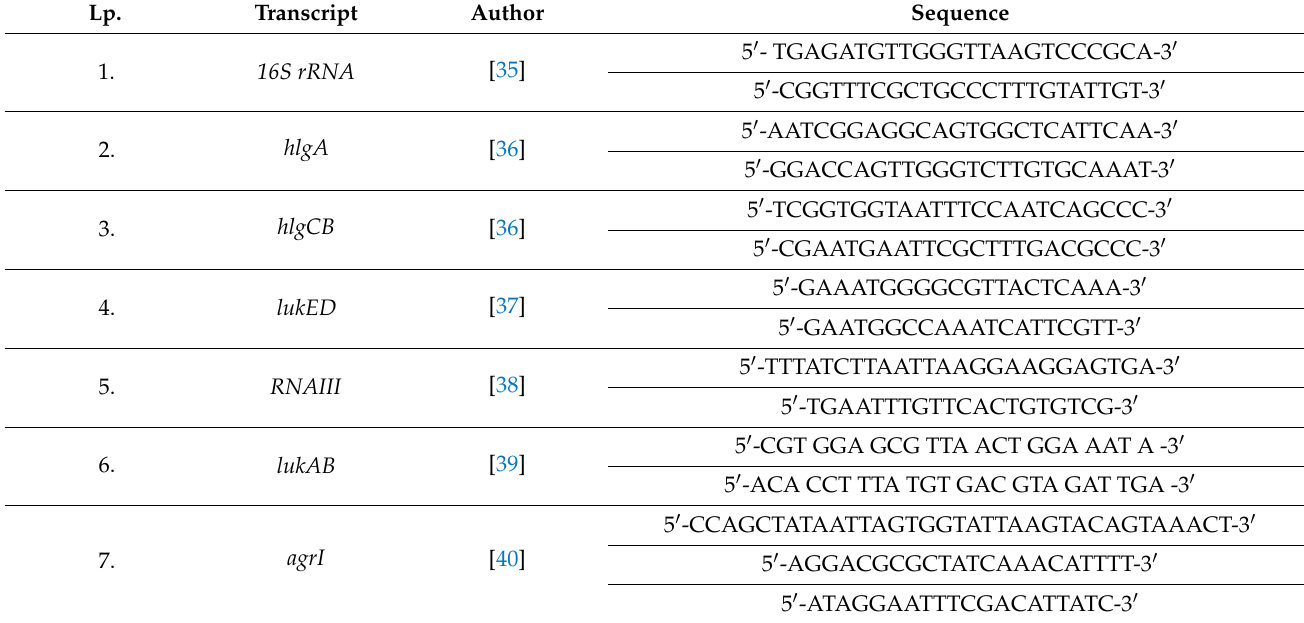
Table 3. Primers used for analysis of the expression of genes encoding virulence factors and main genes involved in regulation of virulence in Staphylococcus by